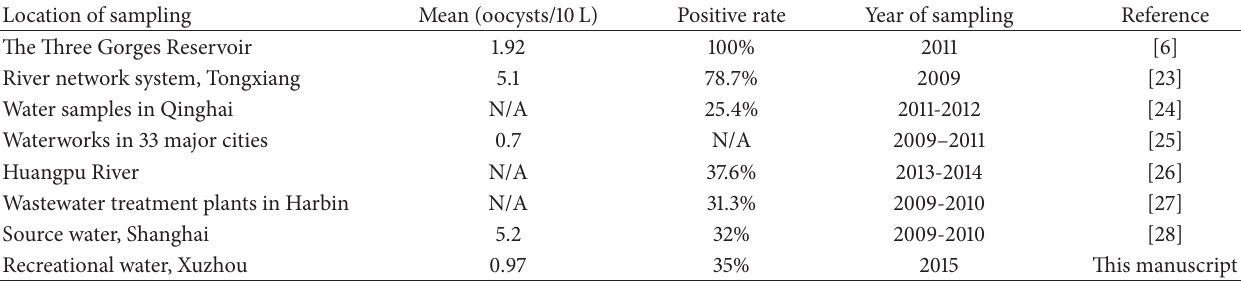
Table 3: Occurrence of Cryptosporidium in water collected from various sites in China.